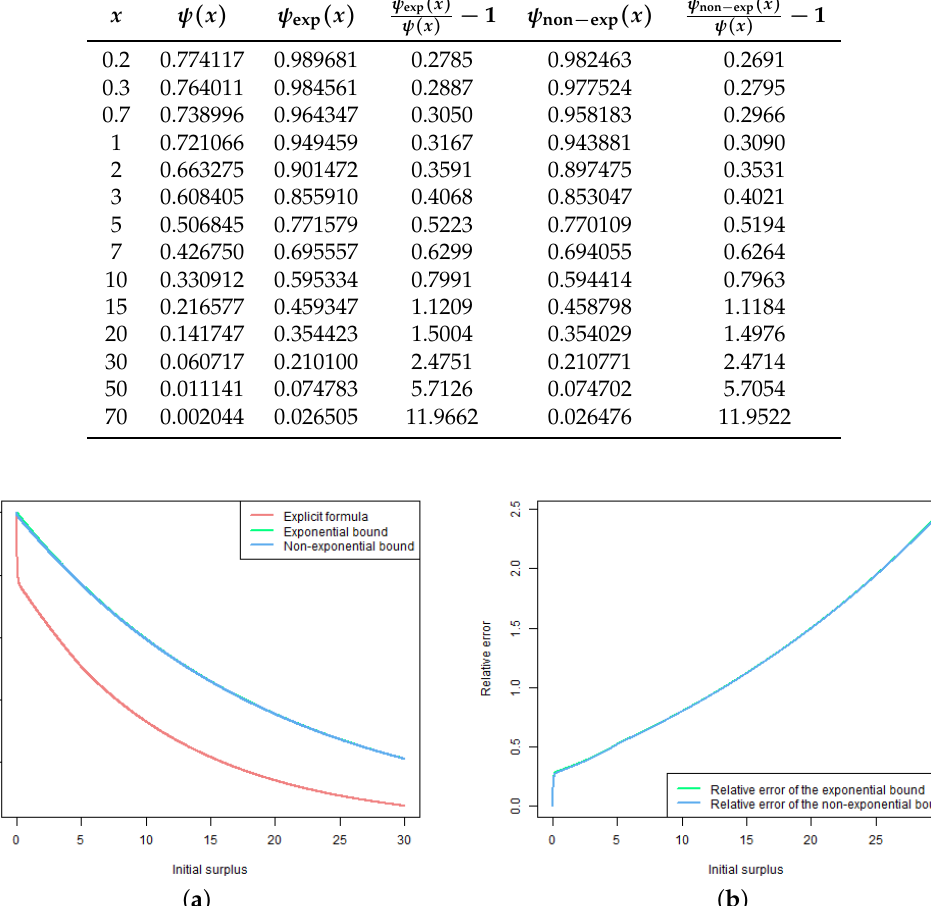
Table 3. Results of computations for the model considered in Example 3.